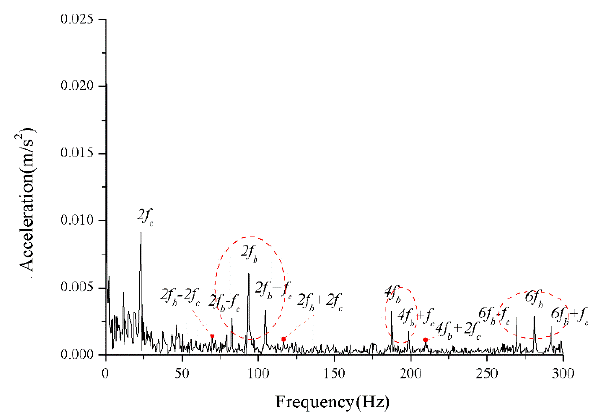
Figure 38. The envelope spectrum of the test signal (slight friction). Figure 38. Acceleration envelope spectrum (slight friction). Figure 38. Acceleration envelope spectrum (slight friction).